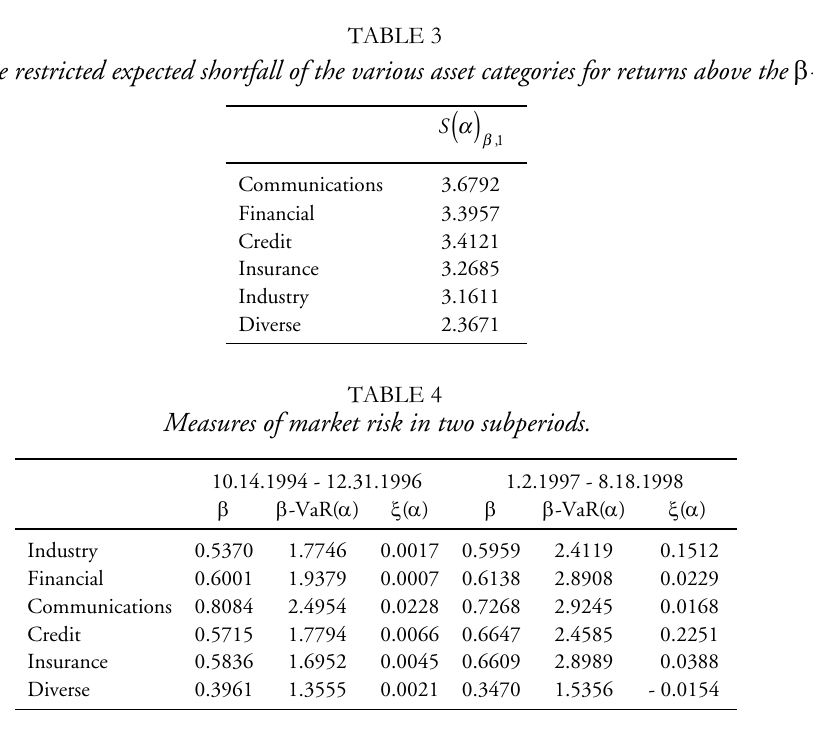
Ranking of assets category according to the two market risk measures in the two subperiods